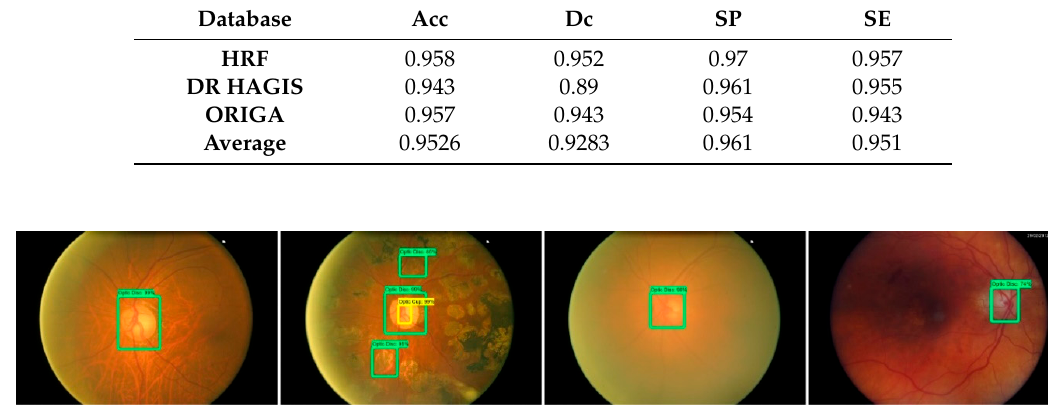
Figure 8. Segmentation Results ( a ). input images, ( b ). localized images, ( c ). OD segmentation, ( d ). OD ground truths, ( e ). OC segmentation, and ( f ). OC ground truths. Table 6. Performance of Proposed method over three databases.